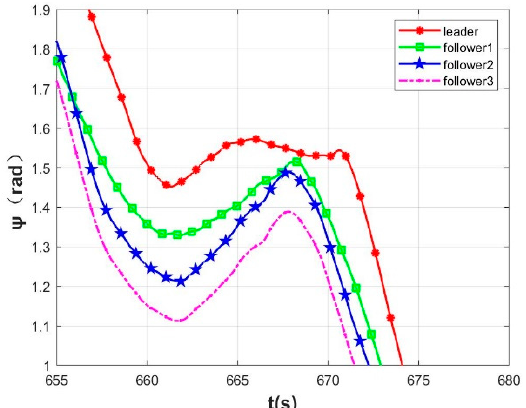
Figure 22. Control effect of the actual flight heading channel of the four aircraft in cooperative formation.